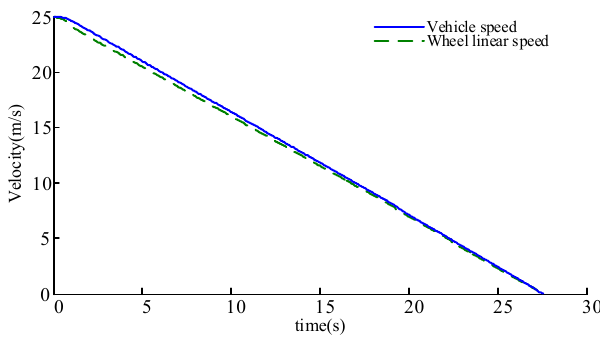
Figure 9. Brake intent from the driver.